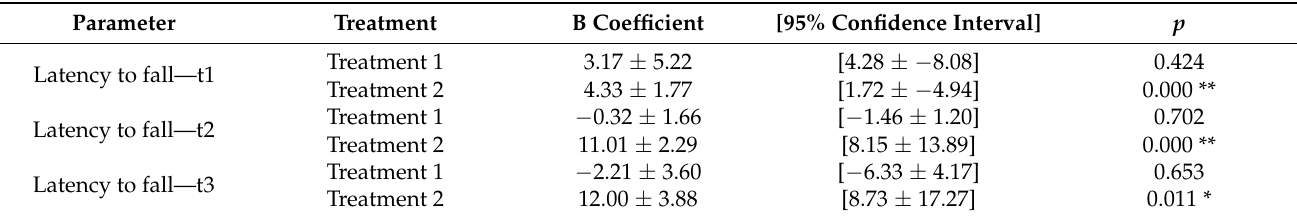
Table 7. Regression analysis of each treatment group compared with the control